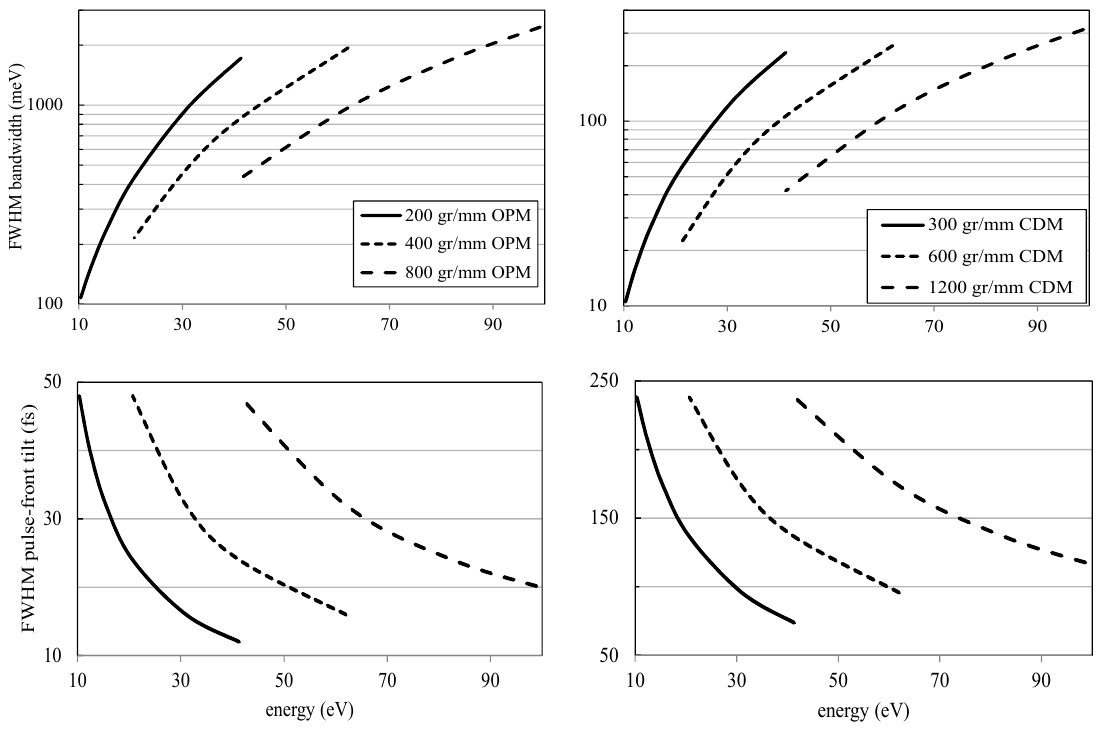
Figure 8. Bandwidth and pulse-front tilt. The bandwidth has been calculated on a 100- μ m slit; the pulse-front tilt has been calculated with a half-width beam divergence of 1.5